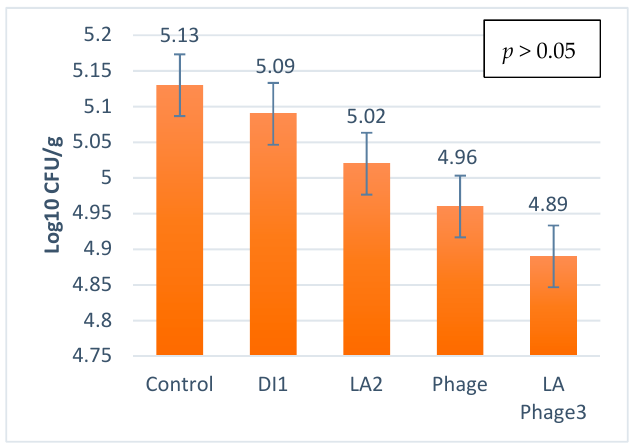
Figure 3. The influence of lactic acid (2.5%), lytic bacteriophage (5%) and a combination of both in marinated and manually tenderized pork slice cores inoculated with Salmonella spp. DI1: Deionized water; LA2: Lactic acid; LA Phage3: Lactic acid phage